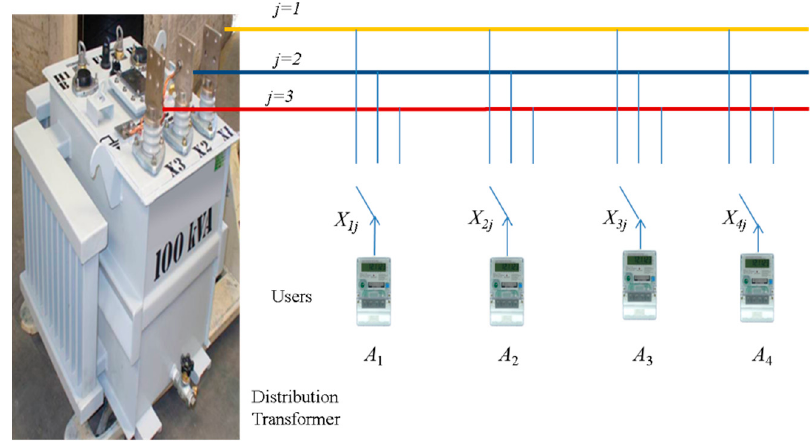
Figure 1. Connection diagram for four loads in a distribution node for phases 1, 2, and 3. X ij are switches to connect each user to only one phase.